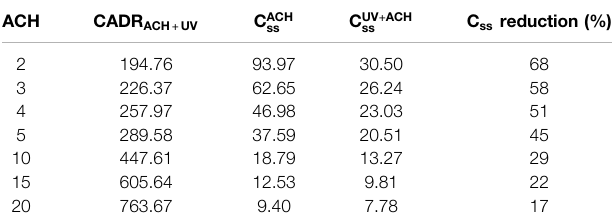
TABLE 2 | Calculated C ss at various ACHs for a 50 m 3 space, with a reactor volume of 200*200 *400 mm (W*H*L), a recirculating rate of 160 m 3 /h,